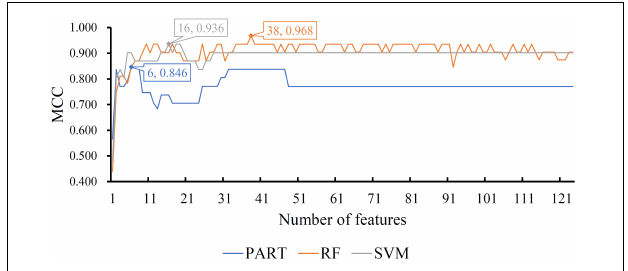
FIGURE 2 | IFS curves with different classification algorithms on different number of methylation features for CRB brain structure. The RF, SVM, and PART yield the highest MCC of 0.968, 0.936, and 0.846, respectively. They are obtained by using top 38, 16, and 6, respectively, features in the